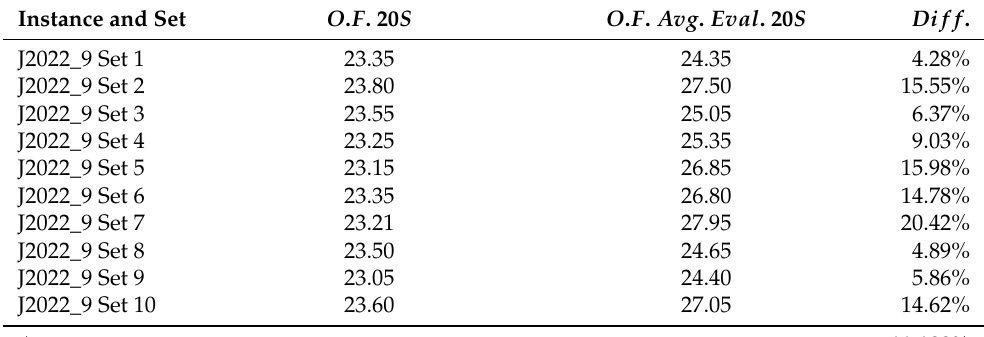
Table 8. Experiment 2 results.